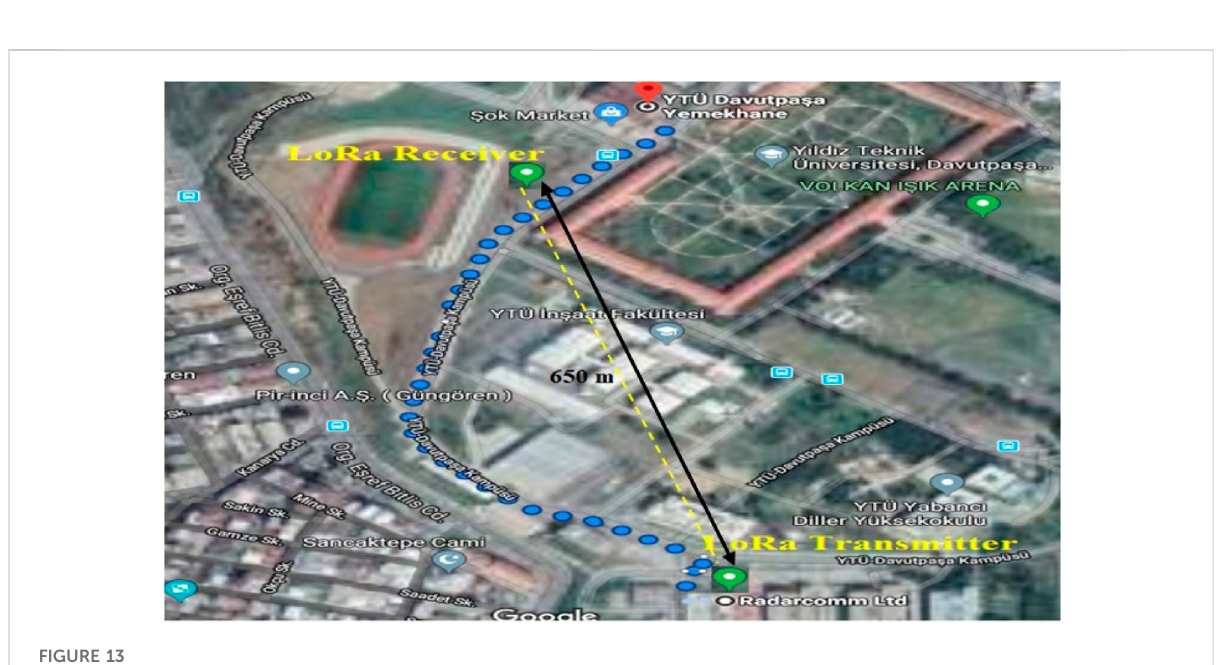
FIGURE 13 GPS locations of the LoRa